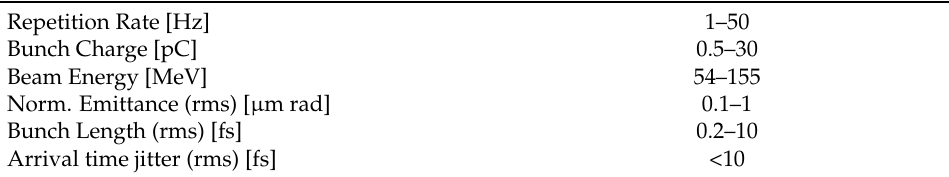
Table 1. Final electron beam parameters planned for ARES.